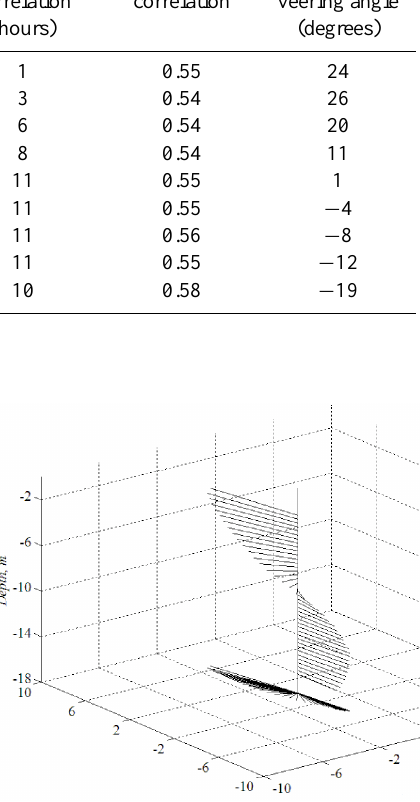
Fig. 11. 3-D representation of the vertical structure of EOF mode- 2. Amplitudes are drawn at the ADCP vertical resolution, namely Figure 11. every